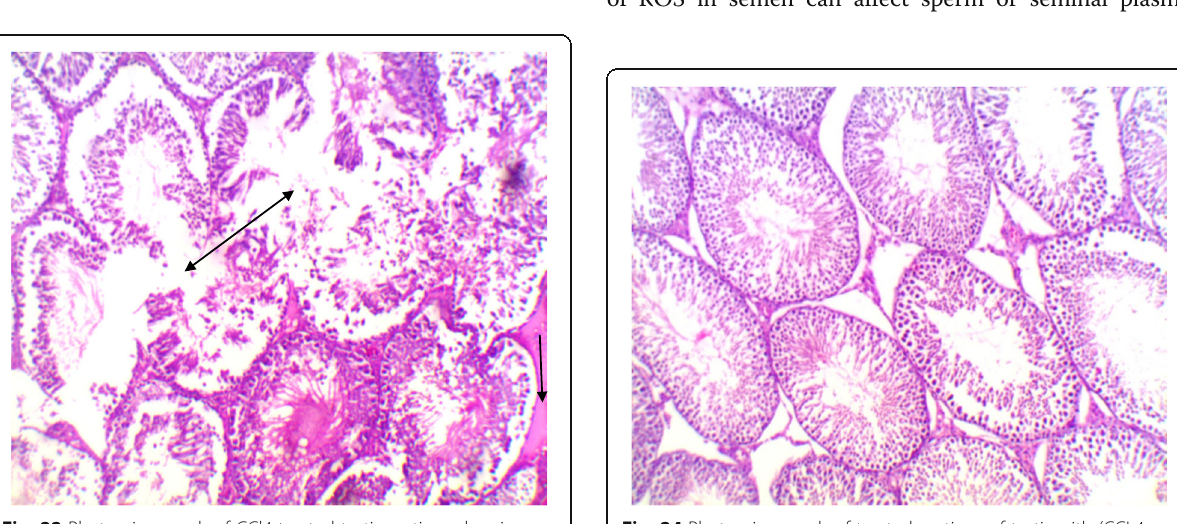
Fig. 24 Photomicrograph of treated sections of testis with (CCL4 + NAC) showing improvement in architecture of sections (H&E; ×